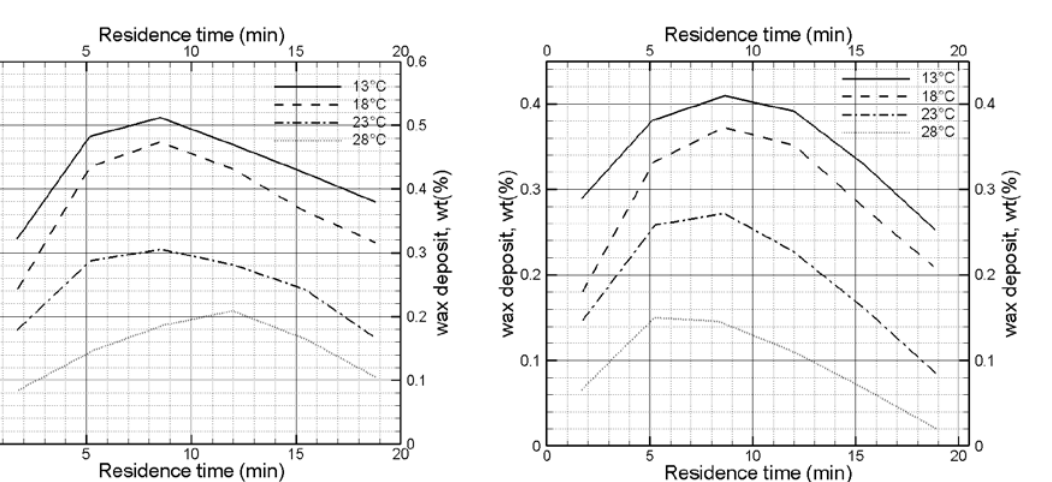
Figure 13 Effect on wax deposition due to residence time at 100 ml/min (Kelechukwu et al., 2010)